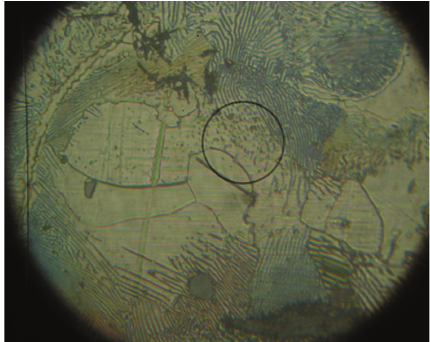
Figure 9: Microstructure in zone A 500x.